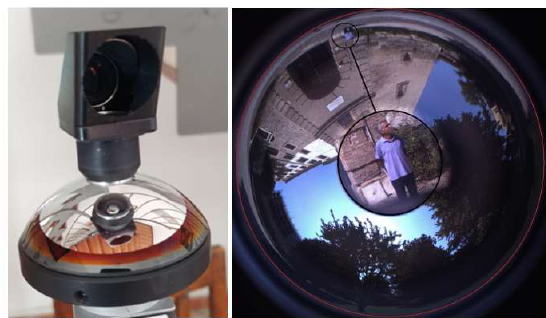
Figure 3 PAN-ROVER head and image